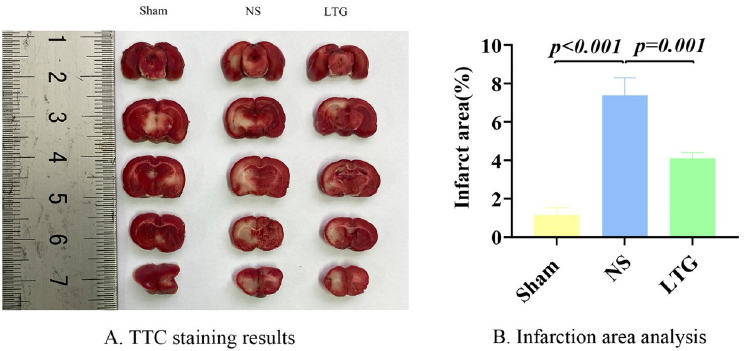
Fig 7. TTC staining and infarct size calculation. Note: A. TTC staining results. B. Statistical analysis of infarct size.